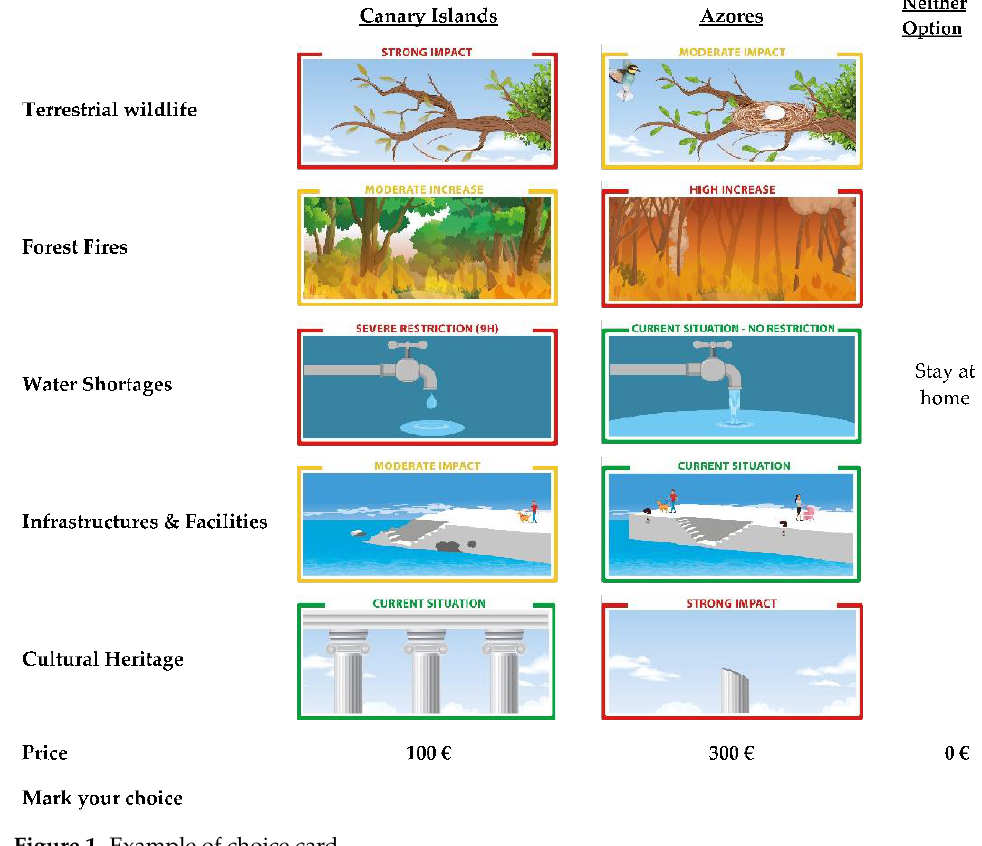
Figure 1. Example of choice card.